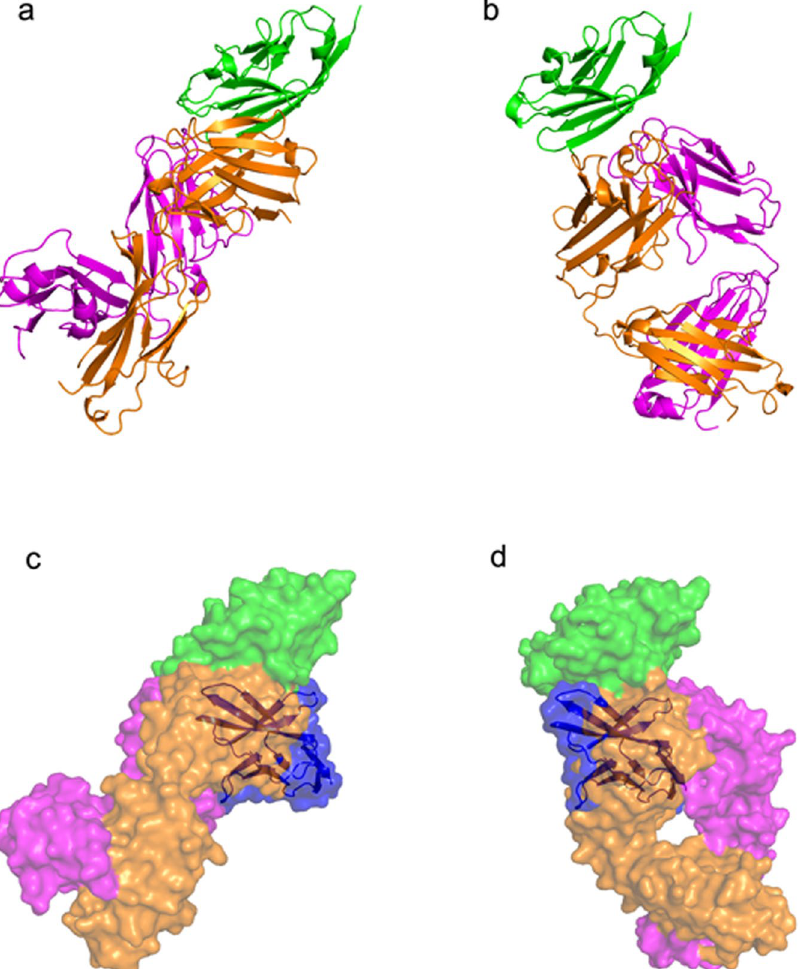
Figure 1. Crystal structures of PD-1 in complex with atezolizumab and durvalumab. ( a ) Ribbon representation of the complex structure of PD-L1/atezolizumab Fab fragment. ( b ) Ribbon representation of the complex structure of PD-L1/durvalumab Fab fragment. ( c ) Surface representation of the complex structure of PD-L1/ atezolizumab Fab fragment. ( d ) Surface representation of the complex structure of PD-L1/durvalumab Fab fragment. PD-L1 and the antibody heavy and light chains are colored green, orange, and purple, respectively. In a – d , PD-L1 is in the same orientation. In c and d , the PD-1/PD-L1 complex (PDB code 4zqk) is superimposed onto the PD-L1 molecule in the PD-L1/anti-PD-L1 complexes with mixed ribbon/surface representation. PD-1 in the PD-1/PD-L1 complex are colored